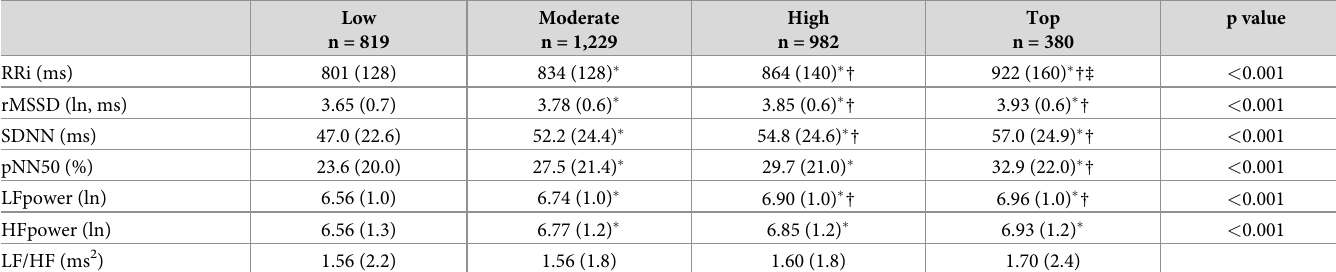
Table 2. The heart rate parameters (n = 3,395) according to reported physical activity level. Values are presented as means (SD) unless otherwise stated.